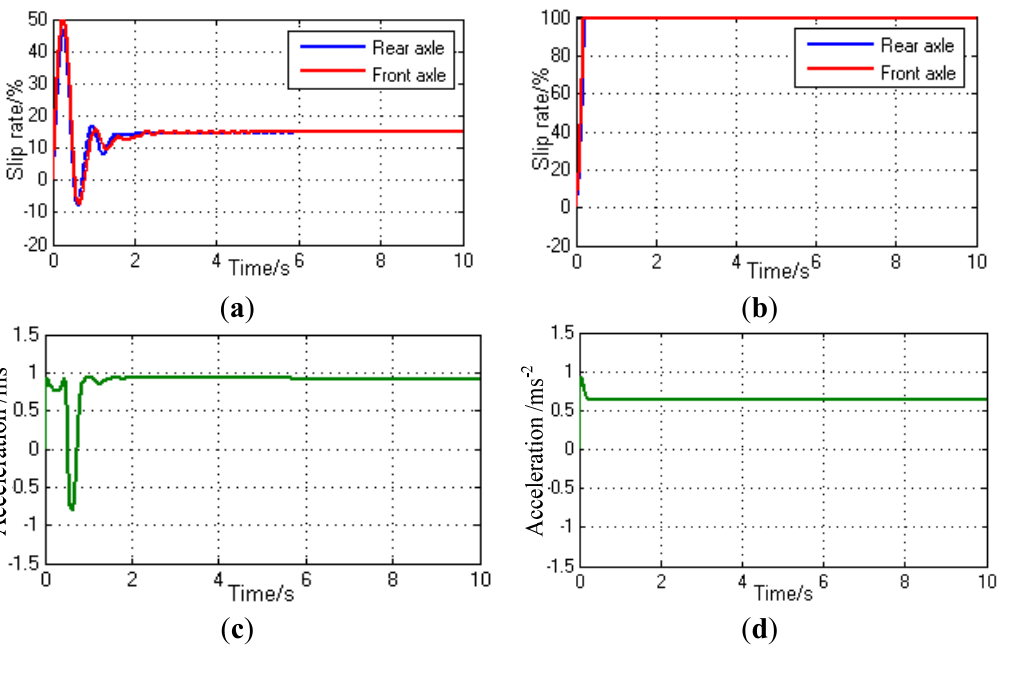
Figure 9. Simulation results of stepping on the pedal heavily on snowy roads: ( a ) Independent control of the optimal slip rate; ( b ) Optimal distribution of inter-axle control; ( c ) Acceleration under independent control of optimal slip rate control; ( d ) Acceleration under optimal distribution of inter-axle torque